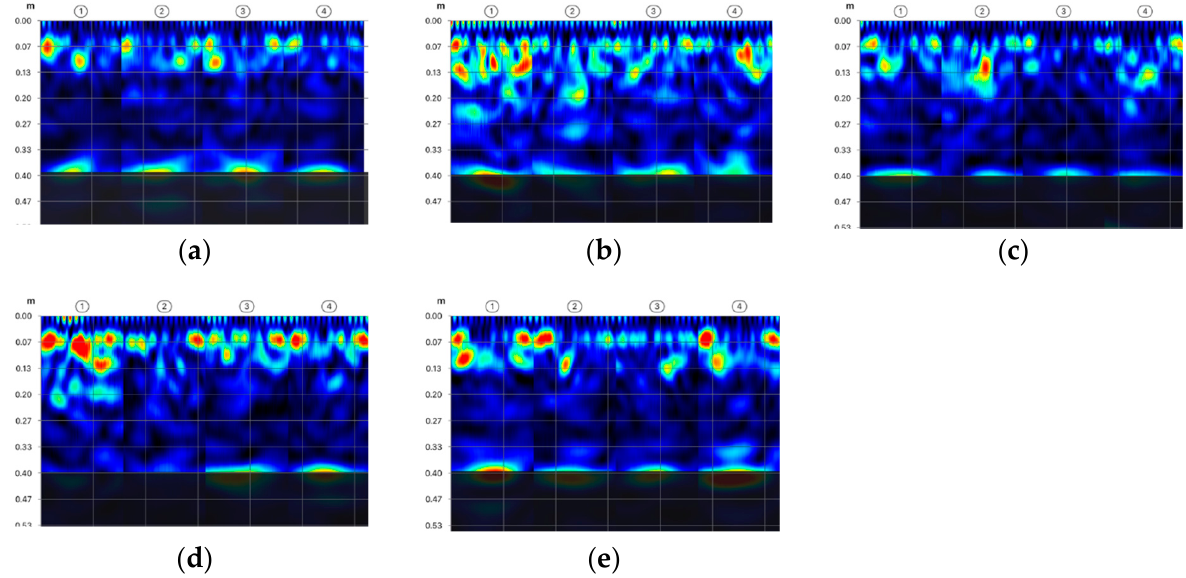
Figure 11. Testing of the location of internal defects in concrete using the ultrasonic method in measuring points: ( a ) P1, ( b ) P2, ( c ) P3, ( d ) P4, ( e ) P5.